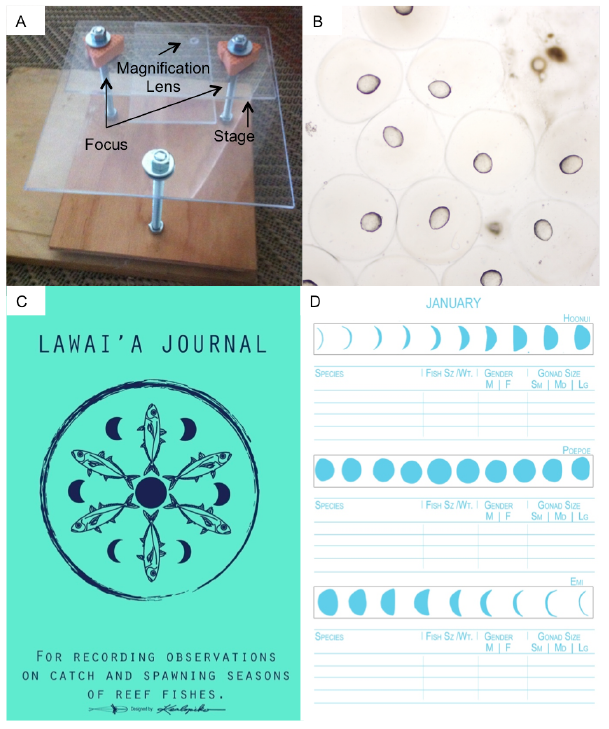
Fig. 2 . Monitoring tools for community-based spawning season assessments. (A) Field microscope that works with smart phones or standard cameras. Built from Plexiglas and plywood for viewing fish oocytes (developing eggs; instructions for construction are available at http://www.instructables.com/ id/10-Smartphone-to-digital-microscope-conversion). (B) An example of a photo from the field microscope showing hydrated k ū m ū ( Parupeneus porphyreus ) oocytes. (C) and (D) Lawai ʻ a logbook (fishing logbook) used to record monthly and lunar patterns in spawning of harvested nearshore fishes.